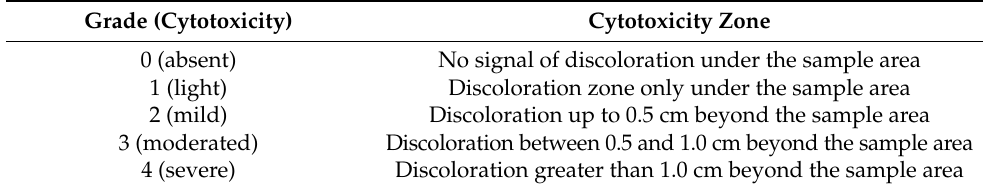
Table 2. Grades of Cytotoxicity (ISO 10993-5:2009). Grade (Cytotoxicity) Cytotoxicity Zone 0 (absent) No signal of discoloration under the sample area 1 (light) Discoloration zone only under the sample area 2 (mild) Discoloration up to 0.5 cm beyond the sample area 3 (moderated) Discoloration between 0.5 and 1.0 cm beyond the sample area 4 (severe) Discoloration greater than 1.0 cm beyond the sample